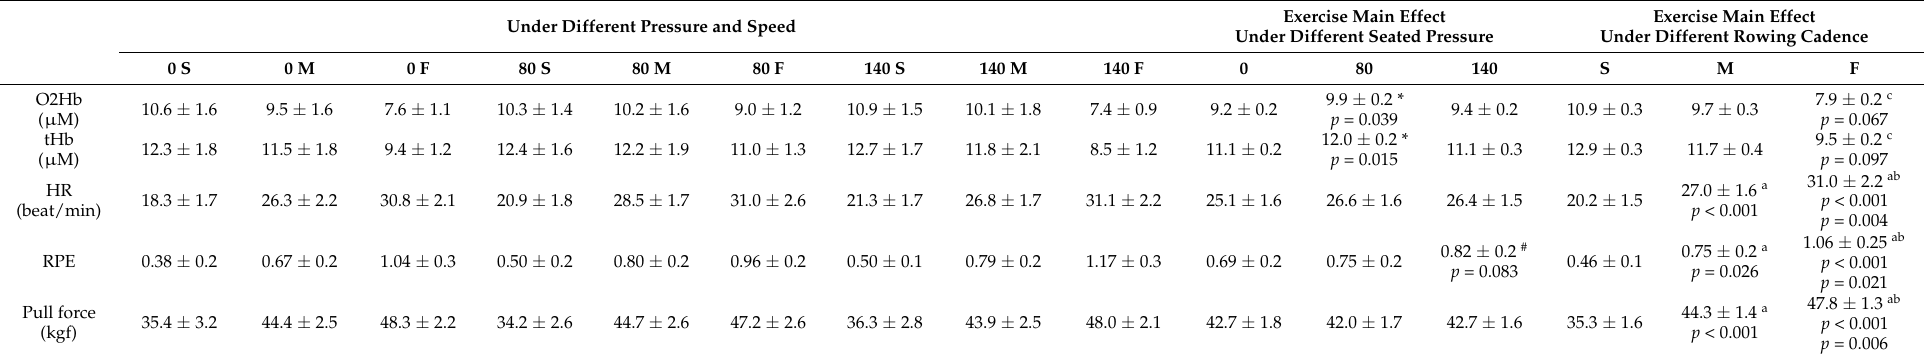
Table 2. Main effects of exercise under different seat pressure and rowing cadence conditions (Mean ±